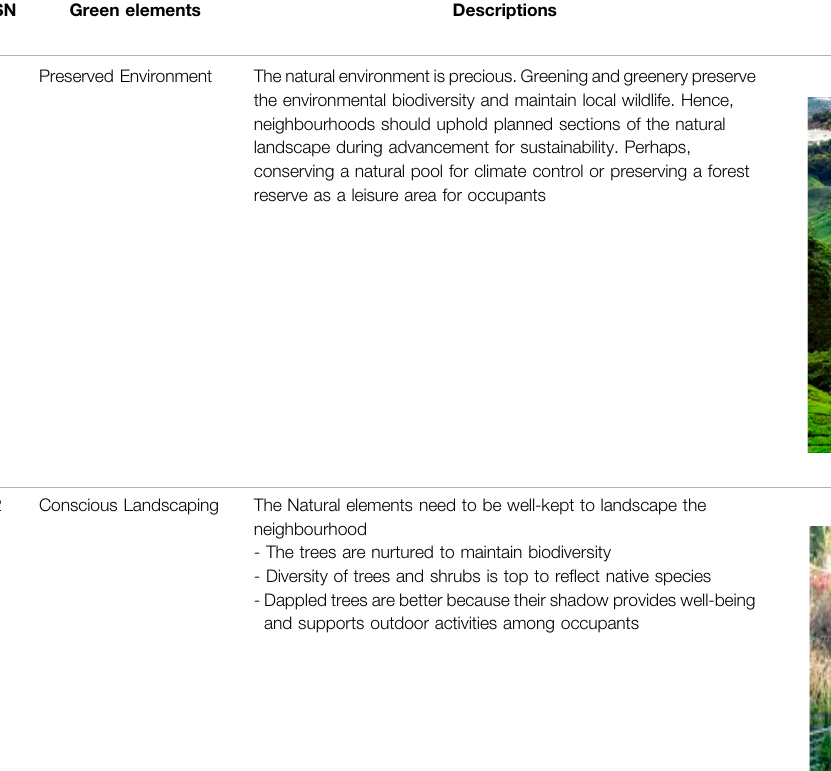
TABLE 2 | Green neighbourhood checklist. SN Green elements Descriptions Illustrations, diagrams, and